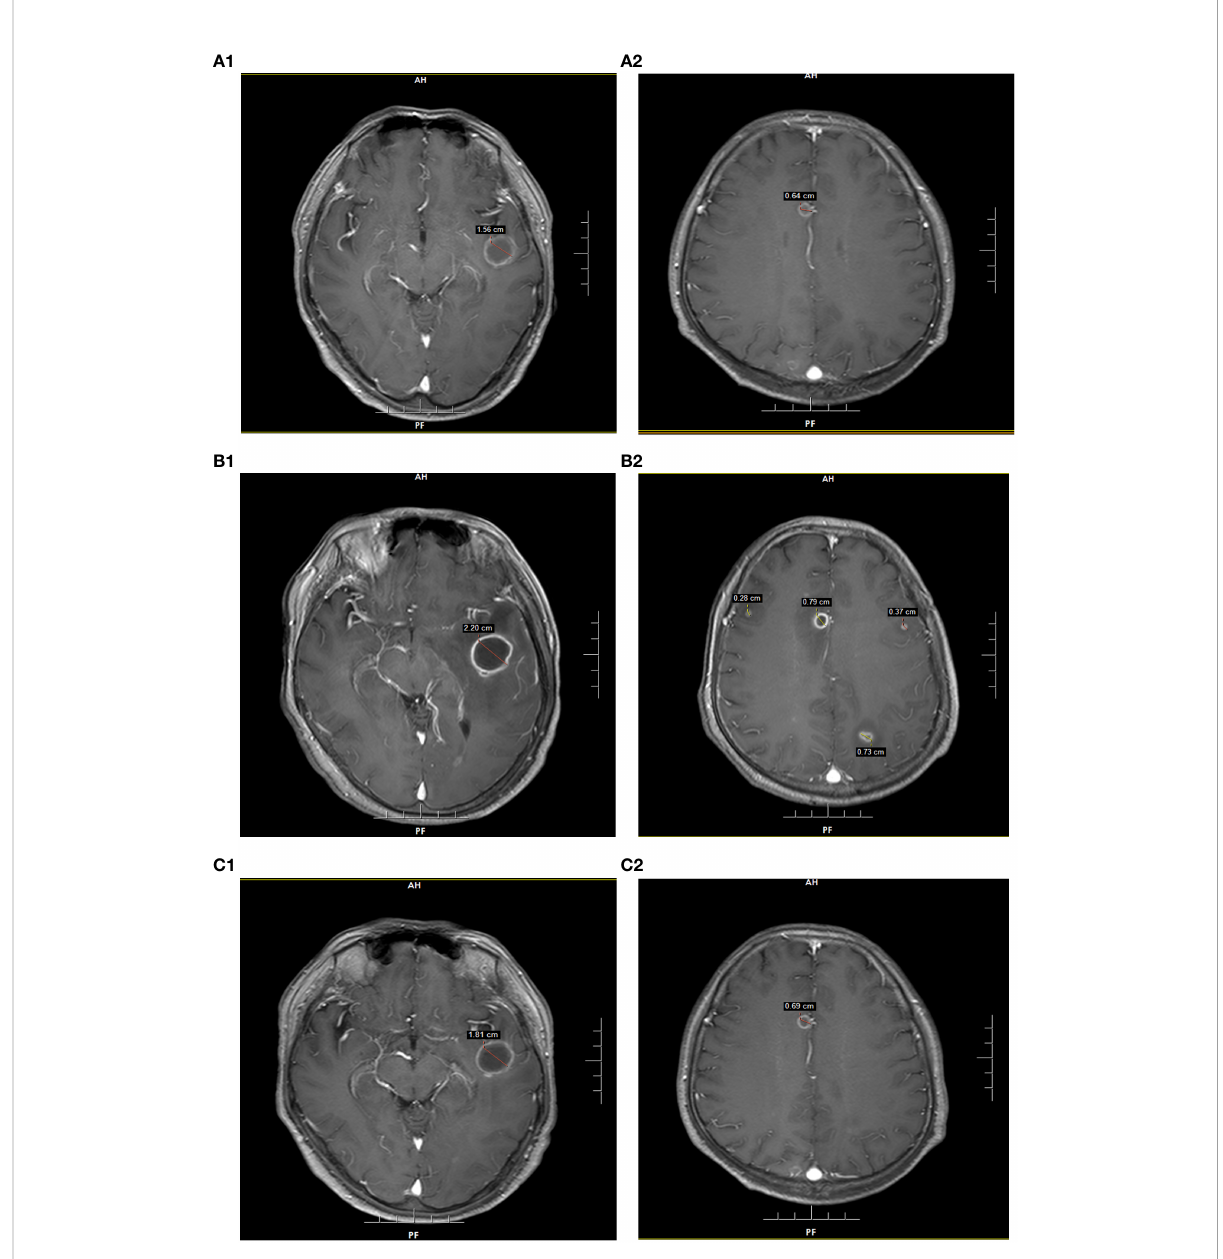
FIGURE 2 Brain MRI fi ndings of patient 2 at the diagnosis of intracranial Aspergillus infection. (A) : MRI showed two lesions with diameters of 1.56 cm and 0.64 cm on POD 7. (B) : MRI showed fi ve lesions with diameters of 2.20 cm, 0.79 cm, 0.73 cm, 0.37 cm, and 0.28 cm on POD 28. (C) : MRI showed two lesions with diameters of 1.81 cm and 0.69 cm on POD